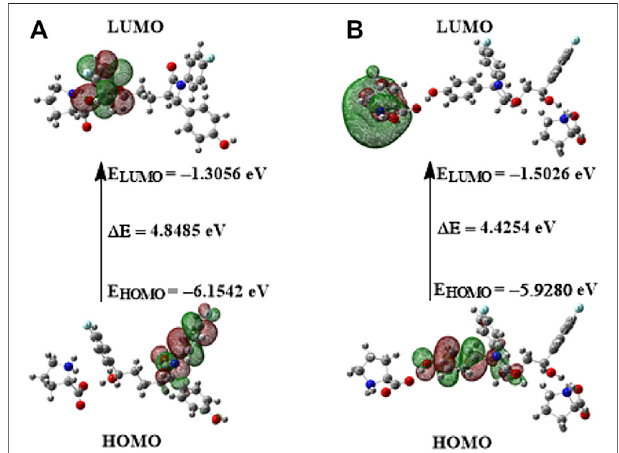
FIGURE 7 | HOMO – LUMO plot of the EZT- L -proline cocrystal with orbitalsinvolvedinelectronictransitions: (A) EZT+L-prolineand (B) EZT+2L-